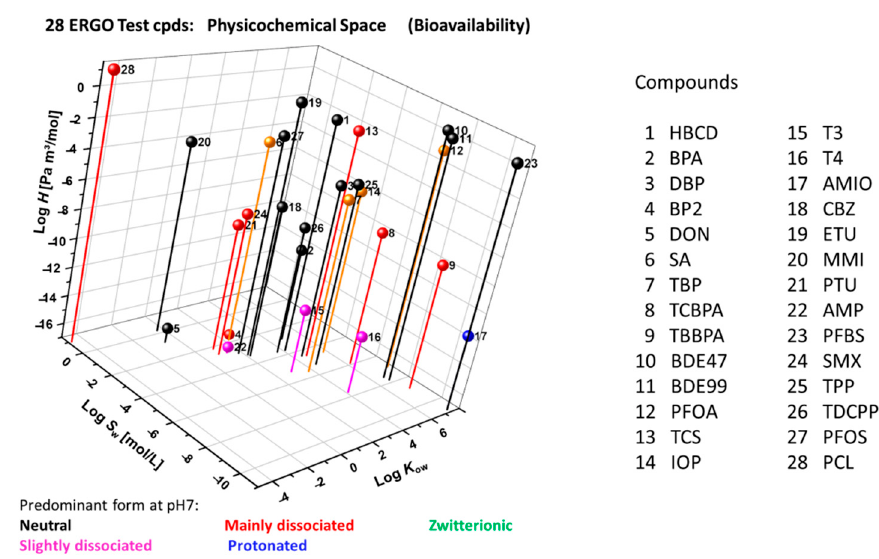
Figure 6. Physicochemical domain of 28 ERGO reference compounds in terms of log K ow (octanol-water partition coefficient), log H (Henry’s law constant) and log S w (water solubility) as calculated through EPISuite ([51], augmented by calculated p K a -driven [52] main speciation.